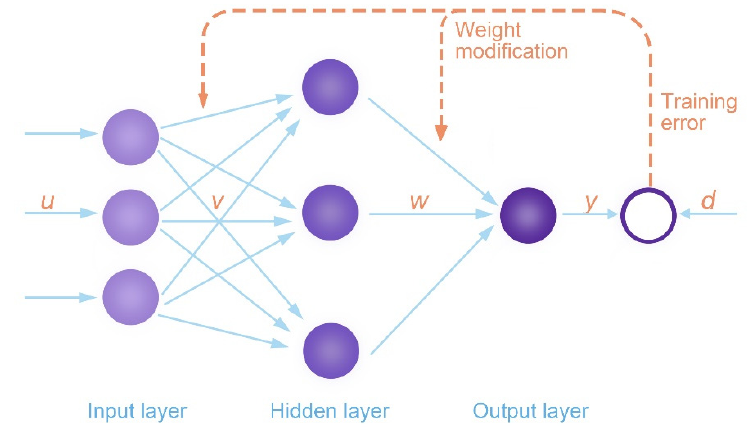
Figure 10. BP neural network structure.